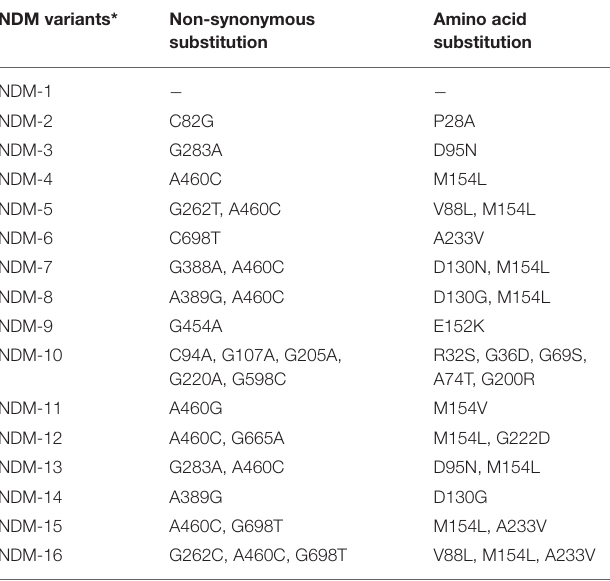
TABLE 2 | Nucleotide and amino acid differences between NDM enzymes. NDM